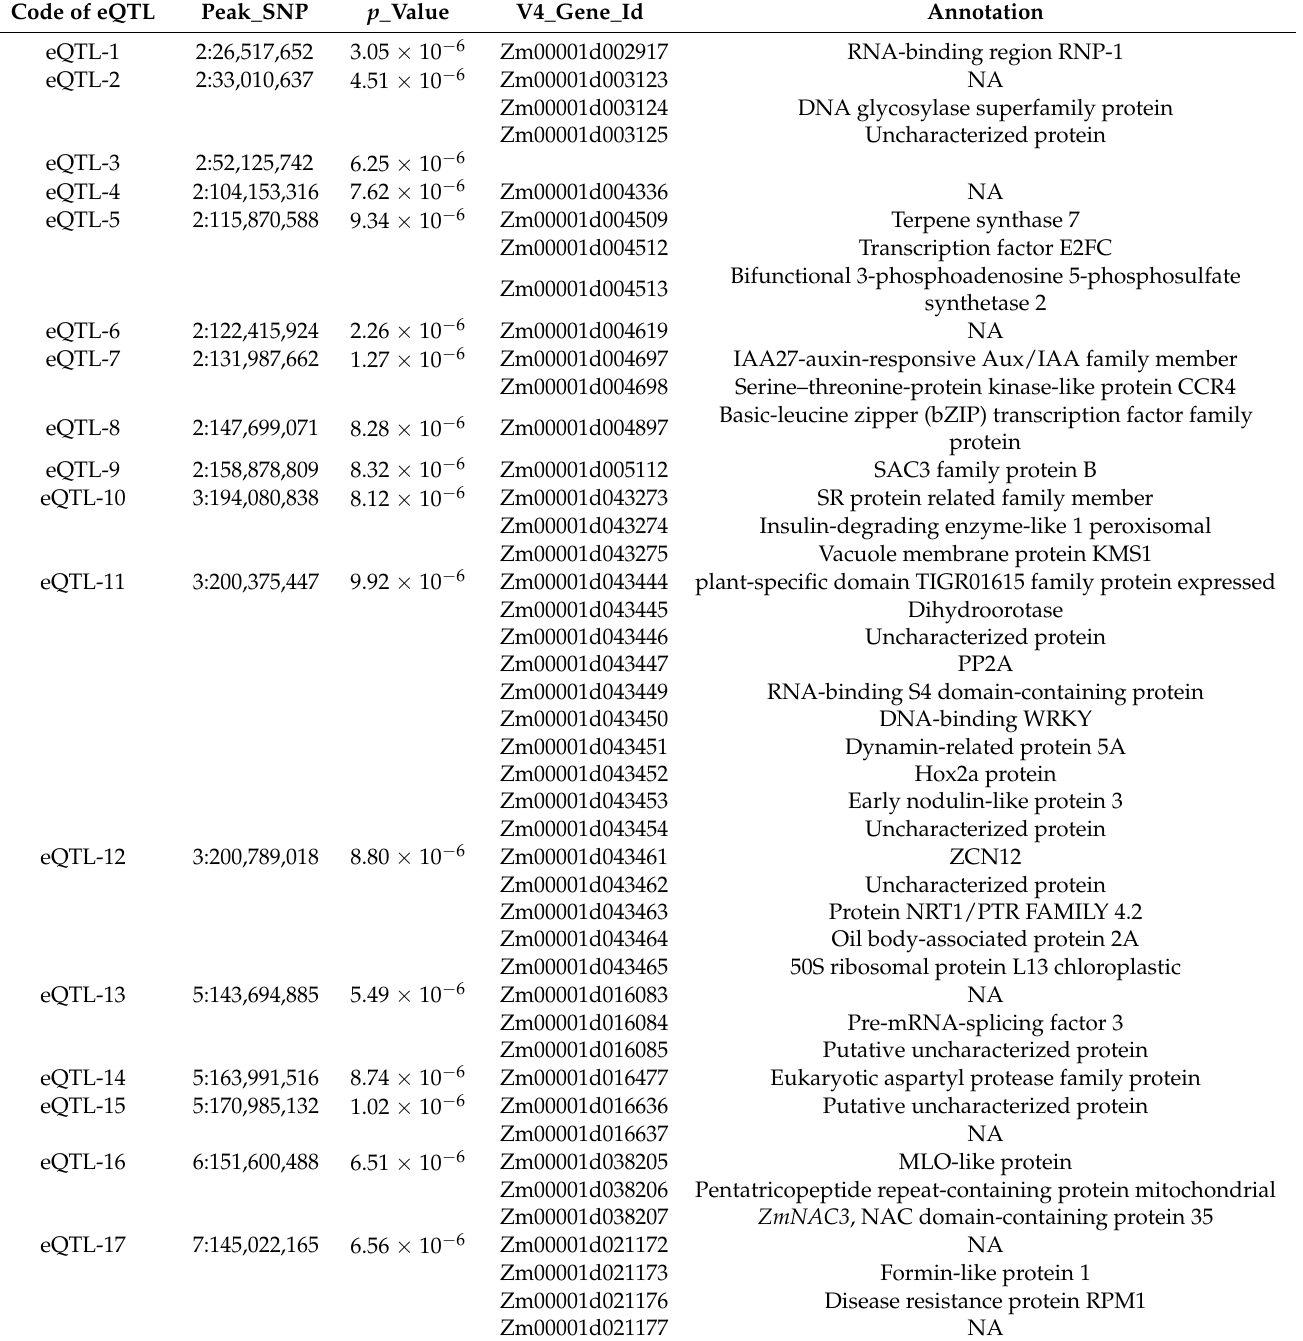
Table 3. List of eQTL for ZmPAT7 and the annotation of candidate